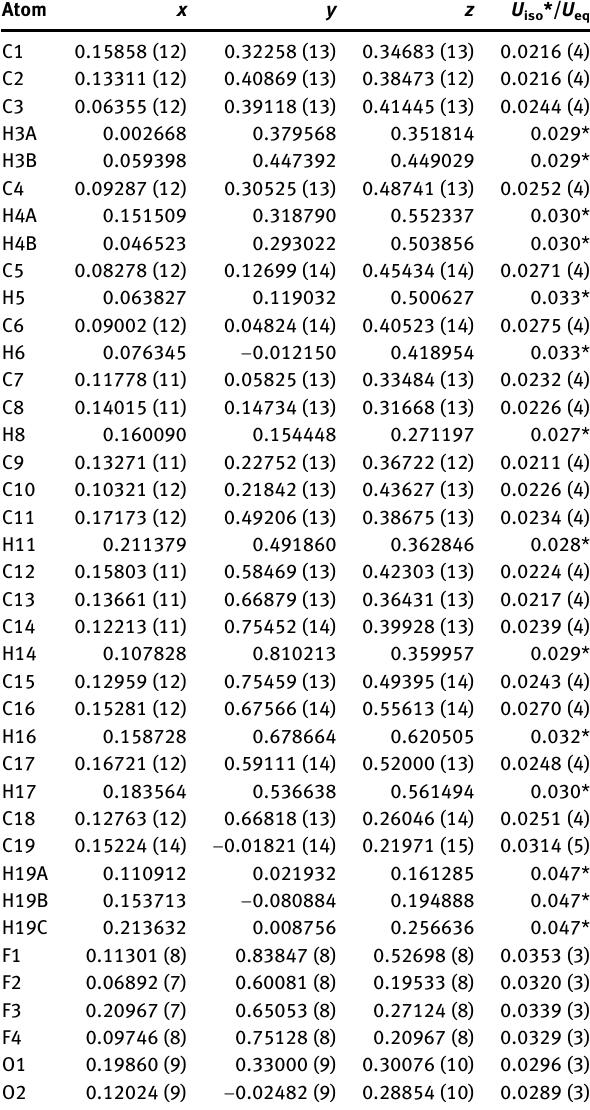
NF- κ B inhibitor with anti-neuroin fl ammatory activities and low toxicity is a potential therapeutic strategy for treating